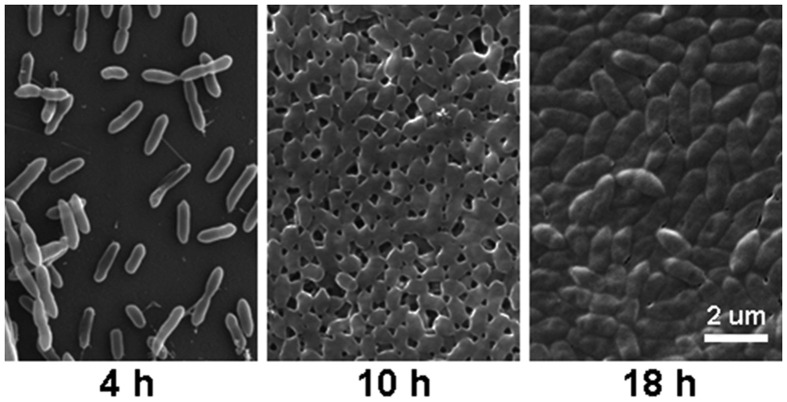
SEM images of one S. maltophilia strain* (10275) biofilms after 4 h (left), 10 h (middle) and 18 h (right).